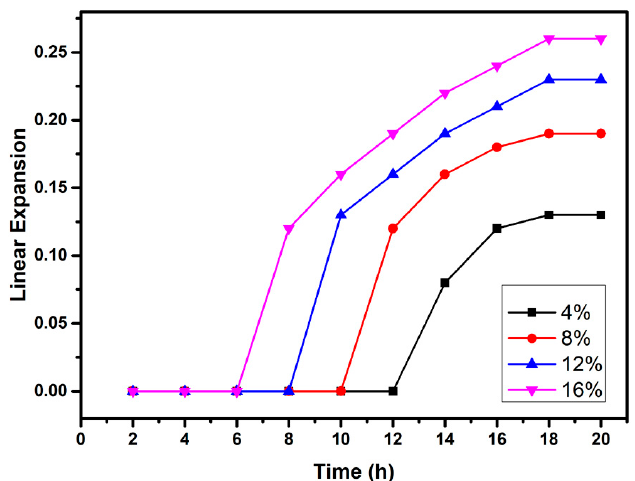
Figure 12. Linear expansion of cement core with different dosage of